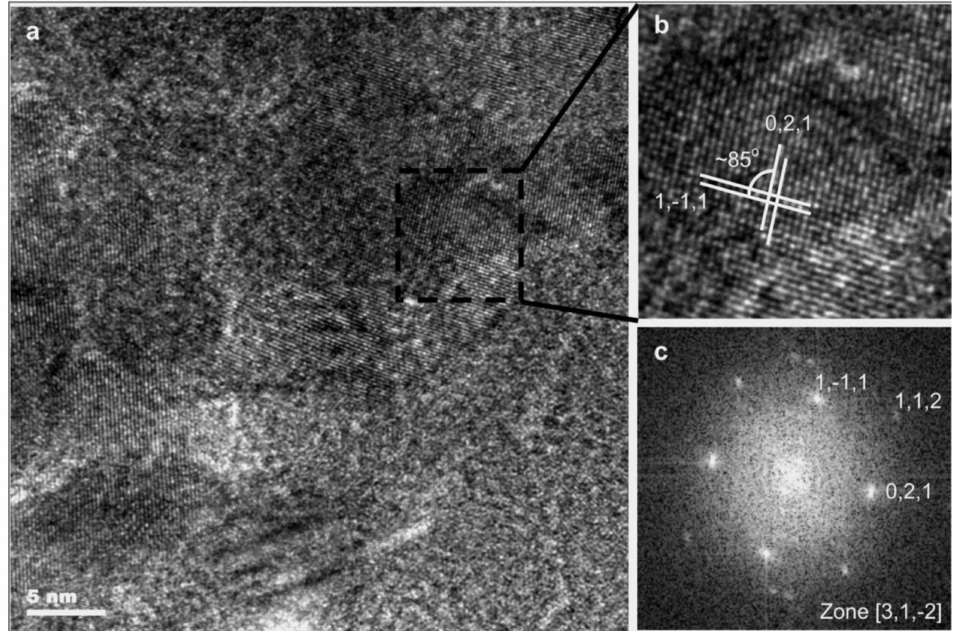
Figure 2. TEM microstructure ( a , b ) and Selected Area Electron Diffraction SAED ( c ) of a nanocrys- talline titanium oxide (TiO 2 ) produced under glow discharge conditions in argon + oxygen plasma (Ar/O 2 =